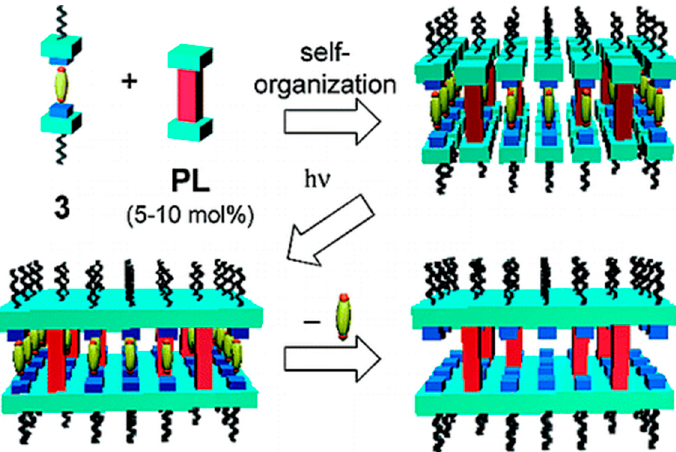
Figure 13. Schematic representation of the process of constructing highly ordered polymers from 3 and PL. 3 monomers doped with PL molecules, self-organising to form a SmA phase, which upon polymerisation, form a polymer sheet. The sheet is supported by the nanopillars after the removal of all of the template molecules. Reprinted with permission from Kishikawa et al., Chem. Mater. , 2008 , 20 , 1931–1935. Copyright (2008) American Chemical Society.